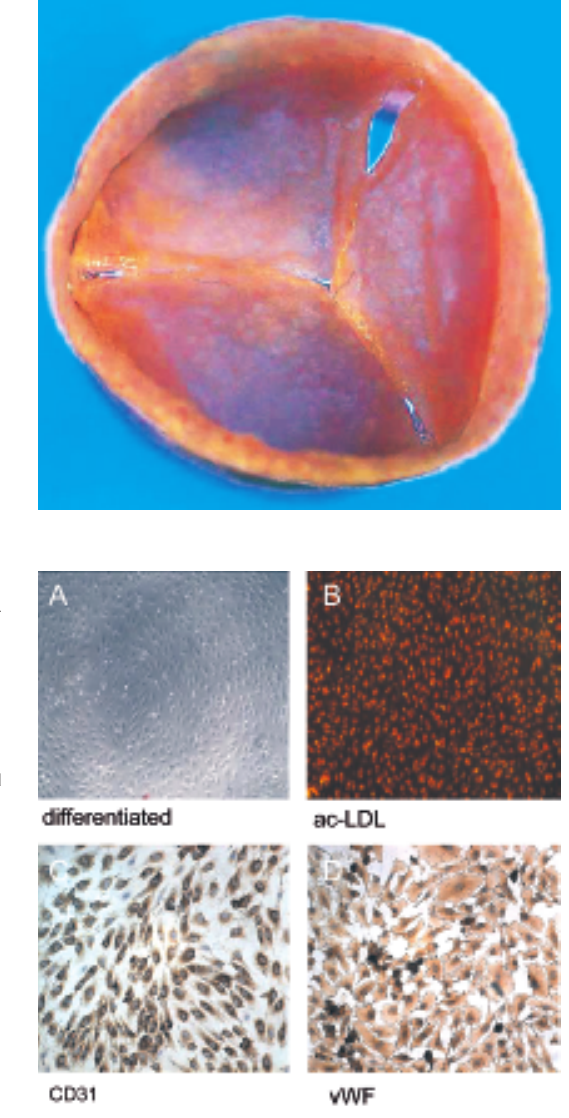
Figure 3 Tissue engineered trileaflet heart valve based on human stromal cells.